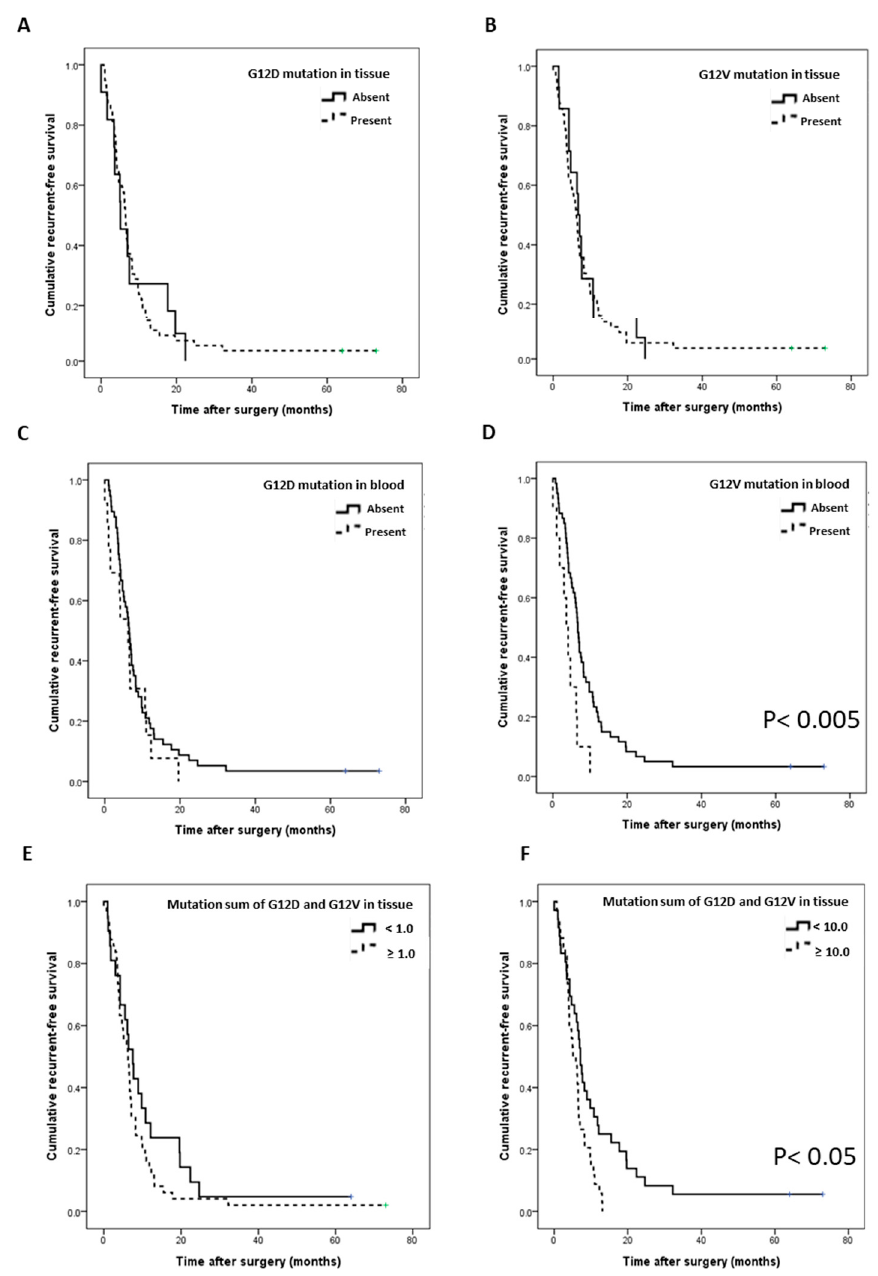
Figure 3. Correlation of the recurrence-free survival (RFS) with the G12D/V mutation ( n = 70). ( A ) RFS according to the presence of the G12D mutation in tissues. ( B ) RFS according to the presence of the G12V mutation in tissues. ( C ) RFS according to the presence of the G12D mutation in blood. ( D ) RFS according to the presence of the G12V mutation in blood ( p = 0.004). ( E ) RFS according to the sum of G12D and G12V mutation burden in tissues (more than 1). ( F ) RFS according to the sum of G12D and G12V mutation burdens in tissues (more than 10, p =